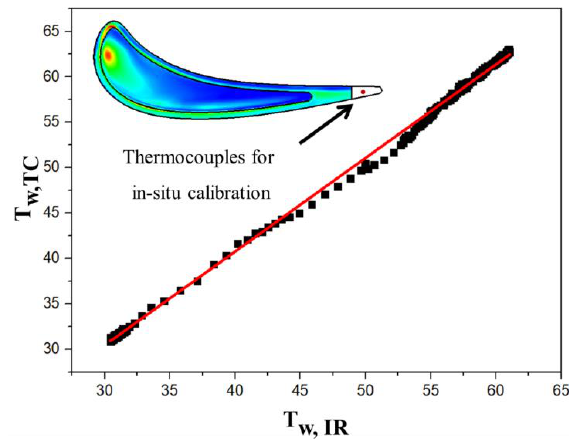
Figure 4. In situ calibration of IR camera and thermocouples.